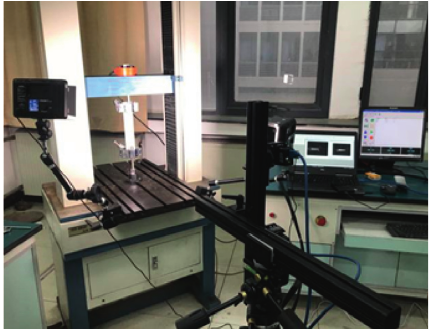
Figure 2: Test setup.